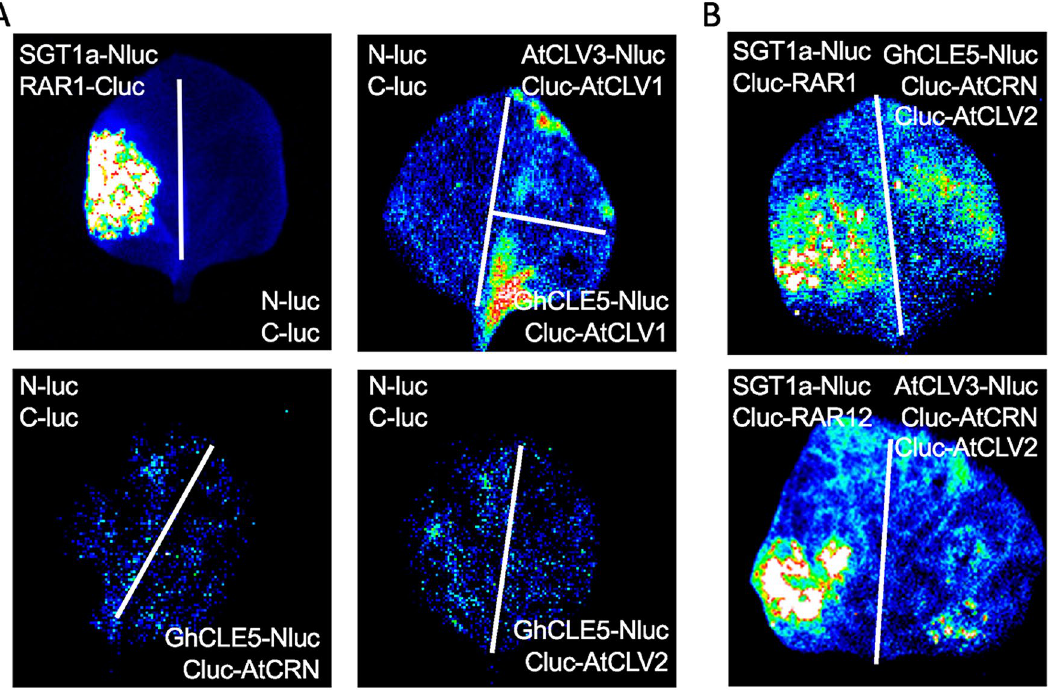
Figure 6. Validation of GhCLE5 binding activity with the CLV1, CLV2, CRN, and CLV2/CRN heterodimers. ( A ) The split-luciferase assay to detect the GhCLE5 binding activity with AtCLV1, AtCLV2, and AtCRN, respectively. The SGT1a-Nluc and RAR1-Cluc are used as positive controls for the binding protein. ( B ) The split-luciferase assay to detect the GhCLE5 binding activity in parallel with the AtCLV2 and AtCRN together. Each examination included three biologic